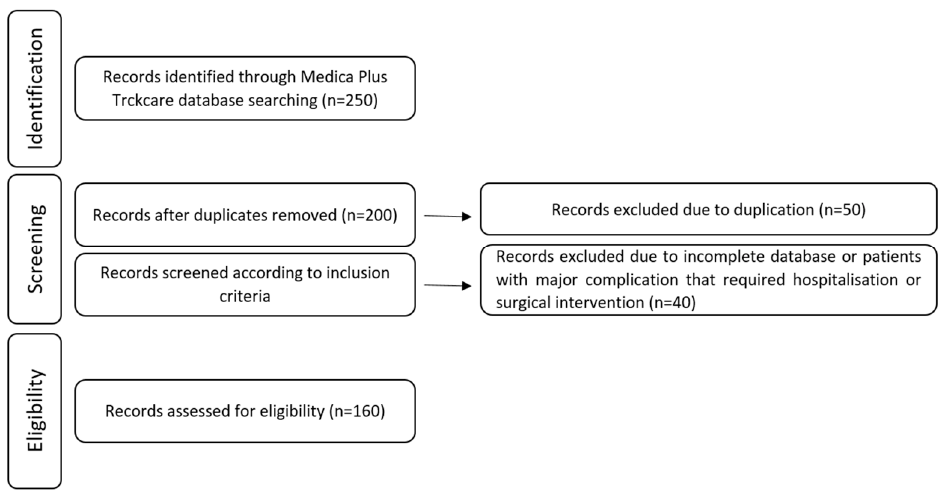
Figure 1. Flowchart of study protocol.